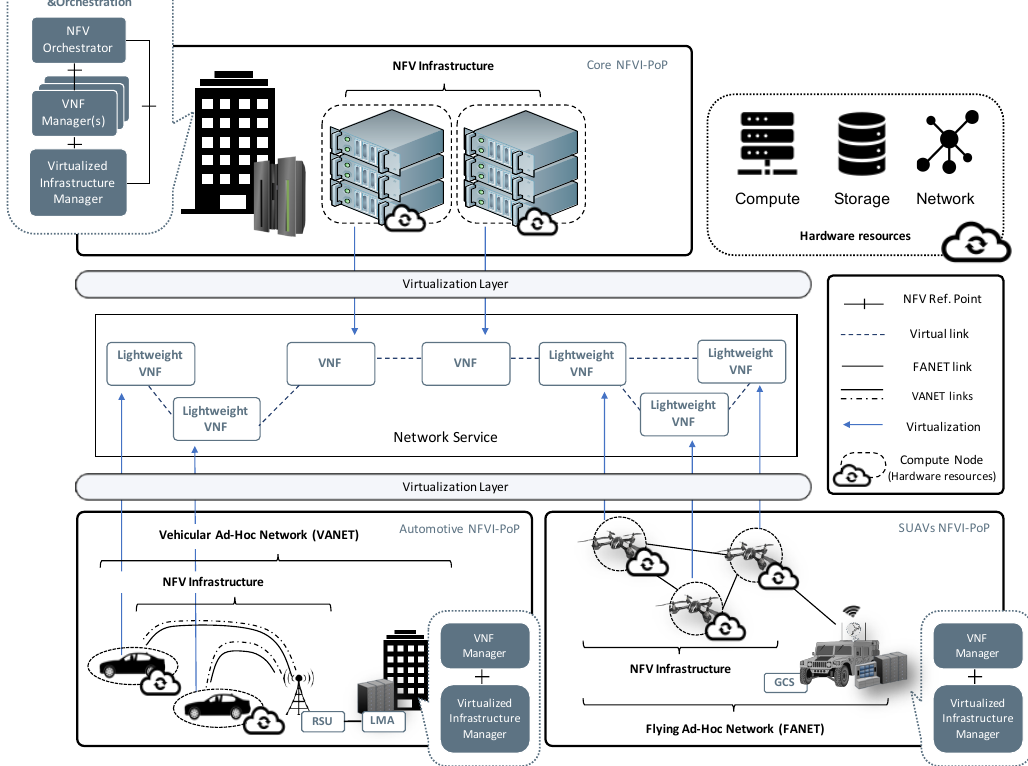
Figure 1. Overall framework